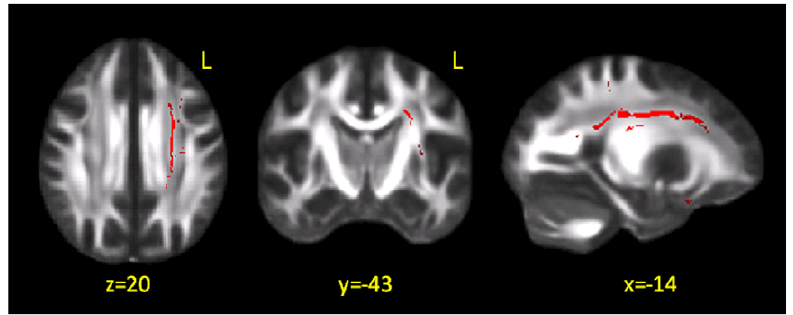
Figure 3. TBSS results in patients vs. controls: axial diffusivity. Red voxels indicate tracts where axial diffusivity (Dax) was found to be increased in patients compared to healthy subjects. These results are overlaid onto the group-averaged FA image. Changes were mainly located within the corona radiata, an area of crossing fibres, where the interpretation of changes in axial and radial diffusivity can be challenging. L=left; x, y, z, indicate the MNI